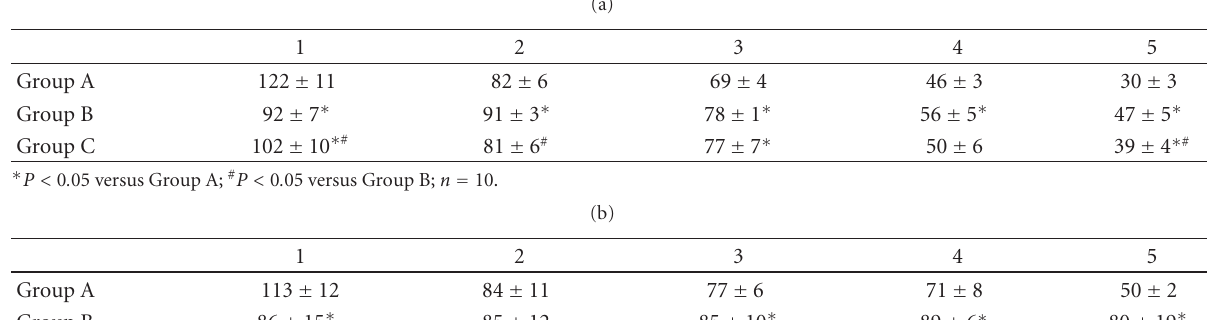
Table 3: (a) Fluorescence intensity of integrin α 3 in di ff erent planes of the IEC (A: control group; B: injury group; C: verapamil group; plane 1 to 5: from the basal surface to the apical surface). (b) Fluorescence intensity of integrin α 5 in di ff erent l planes of the IEC (A: Control group B: Injury group; C: Verapamil group; plane 1 to 5: from the basal surface to the apical surface). (c) Fluorescence intensity of integrin β 1 in di ff erent planes of the IEC (A: Control group; B: Injury group; C: Verapamil group; planes 1 to 5: from the basal surface to the apical surface). (d) Fluorescence intensity of integrin β 5 in di ff erent planes of the IEC (A: Control group; B: Injury group; C: Verapamil group; planes 1 to 5: from the basal surface to the apical surface). (e) Fluorescence intensity of integrin α 2 in di ff erent planes of the IEC (A: Control group B: Injury group; C: Verapamil group; planes 1 to 5: from the basal surface to the apical surface).